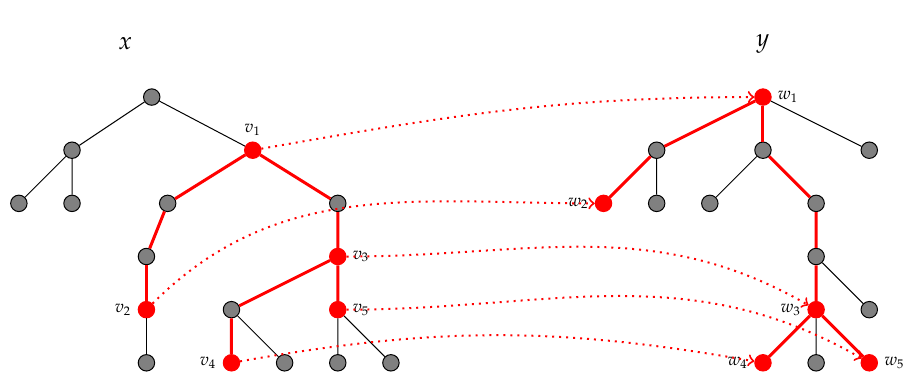
Figure 5. Agreement subtrees and { ( v i , w i ) } i = 1,...,5 ∈ M E x , y .